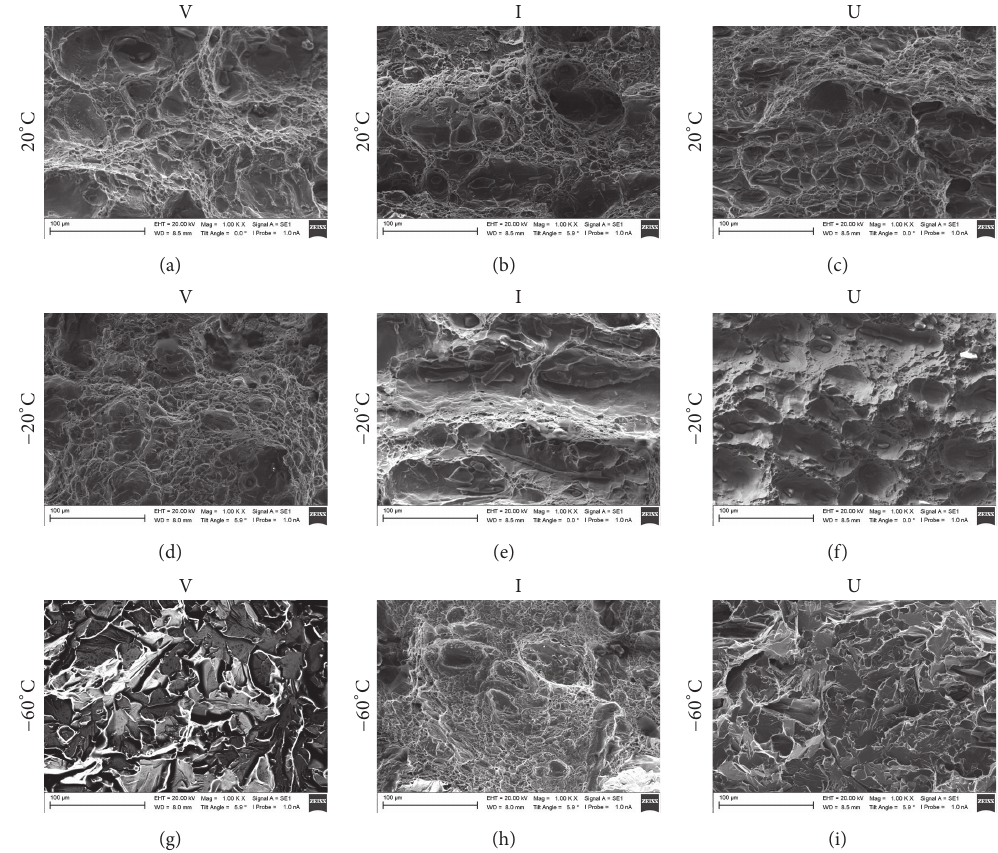
Figure 5: SEM fracture surfaces of crack initiation zone in specimens with different-shaped notches after impact bending test at different temperatures.